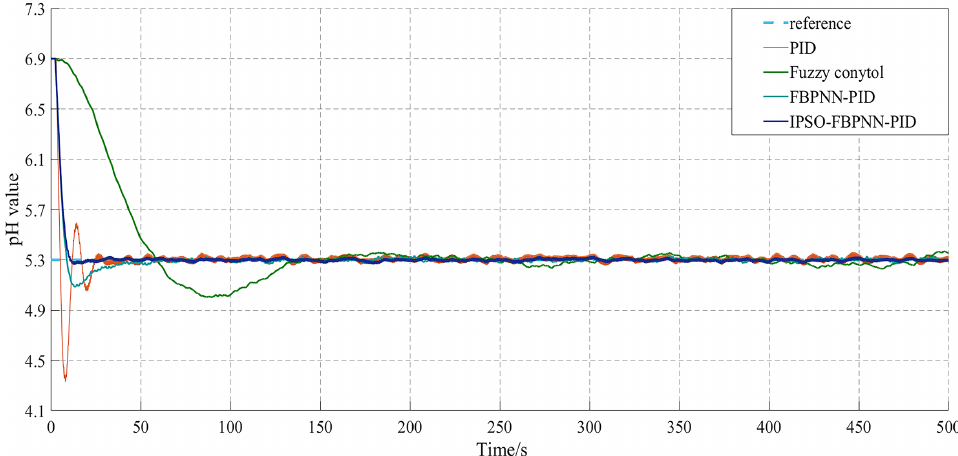
Figure 18. Comparative analysis of different control algorithms when regulating pH from 6.9 to 5.3. Table 3. Table of performance parameters for pH from 7.1 to 6.3.